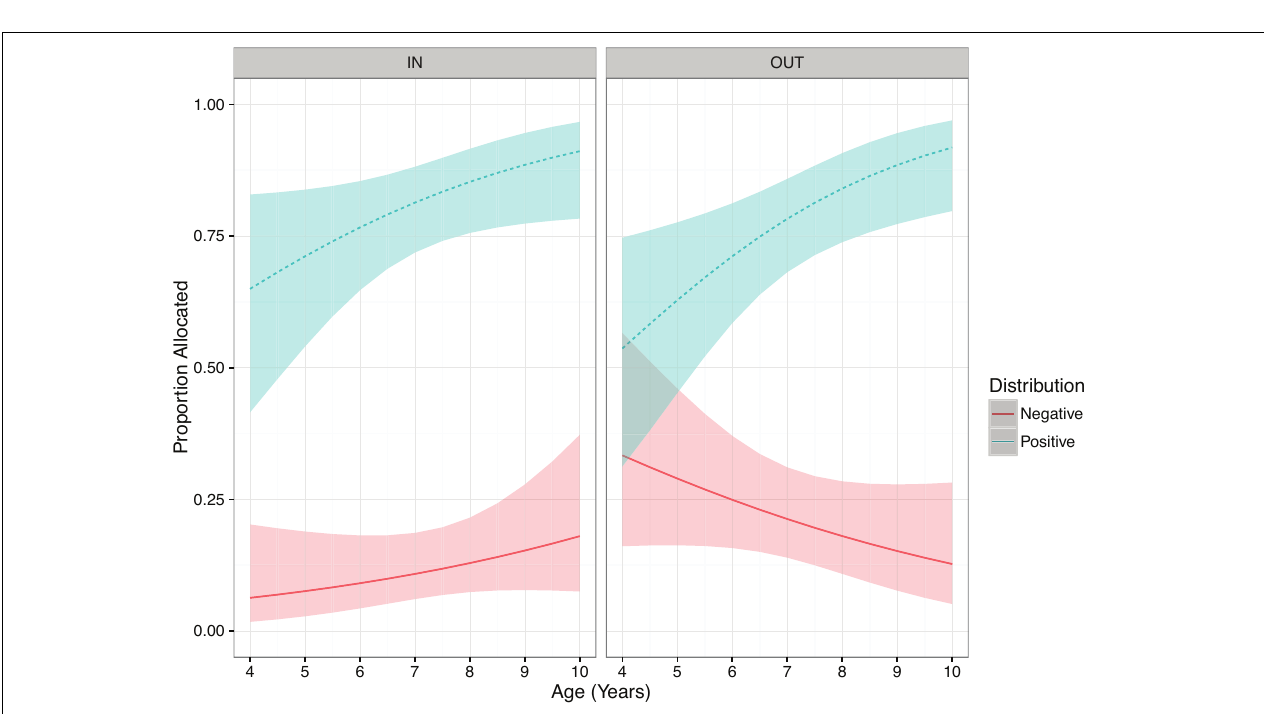
FIGURE 4 | Predicted proportion allocated for males on Care trials, Distribution facetted by Group, plotted over age. Ribbons show 95% confidence intervals.